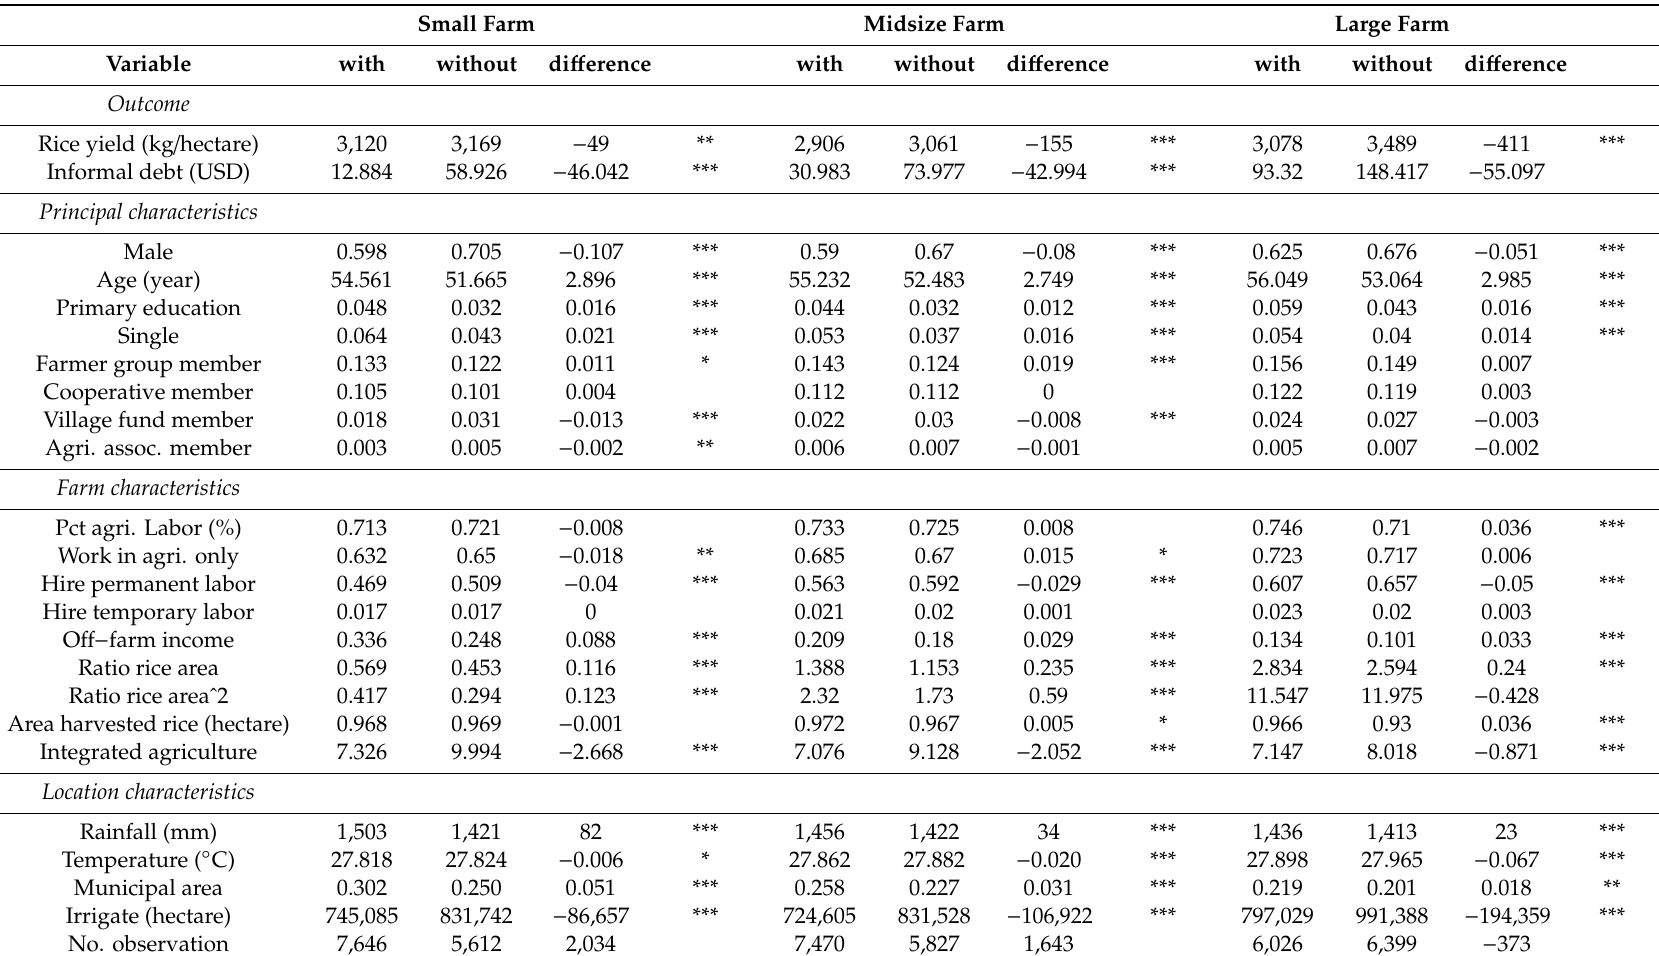
Table 2. Mean values of selected variables for farm types with / without full land ownership. Small Farm Midsize Farm Large